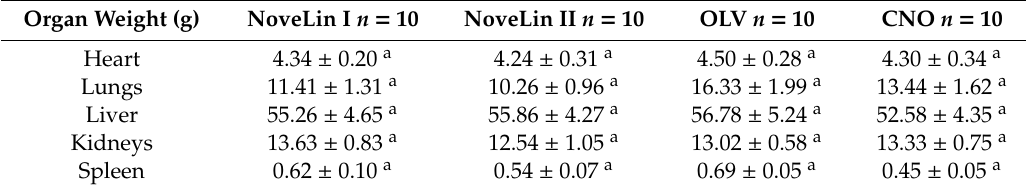
Table 4. E ff ect of dietary intervention on various organ